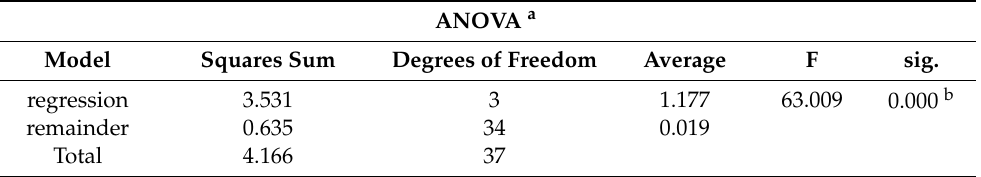
Table 8. Analysis of variance for UCS model.